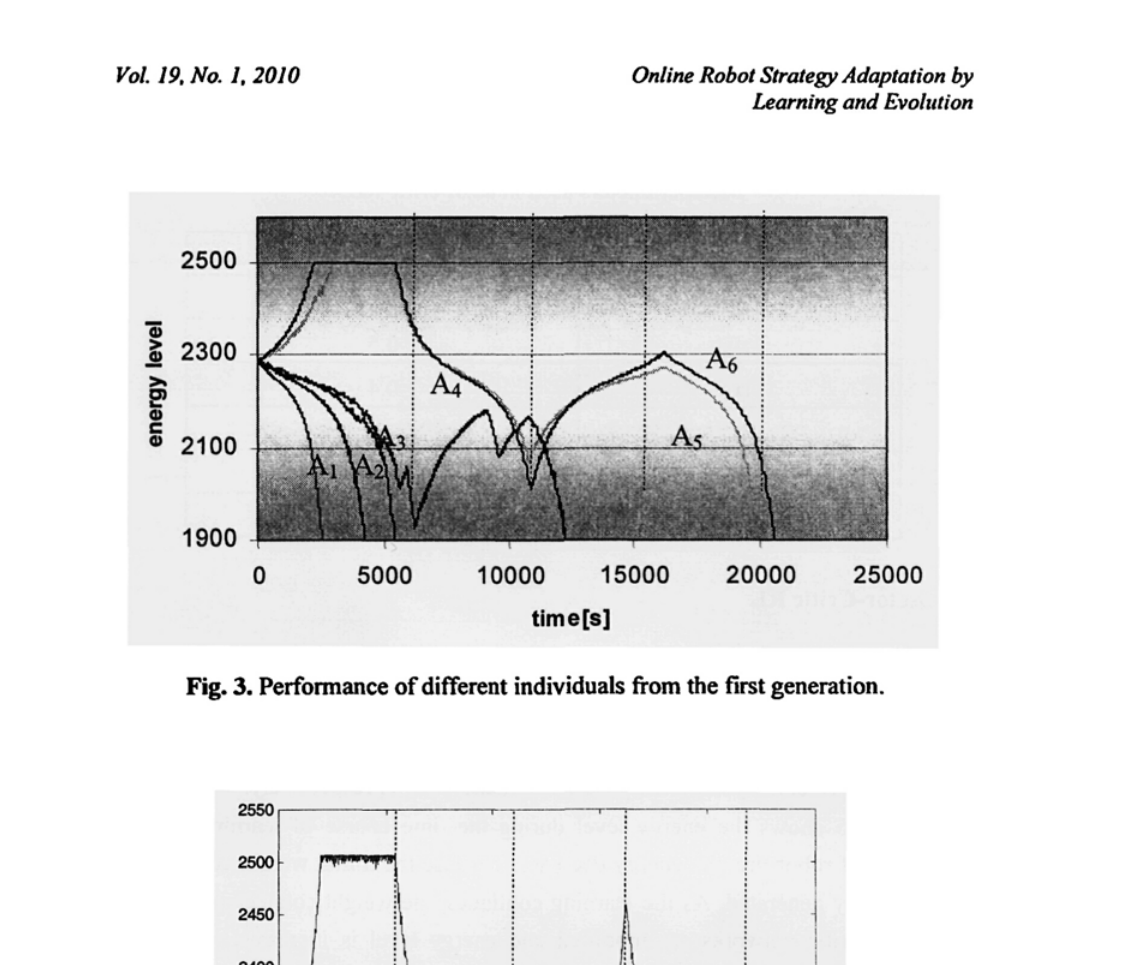
Fig. 3. Performance of different individuals from the first generation.